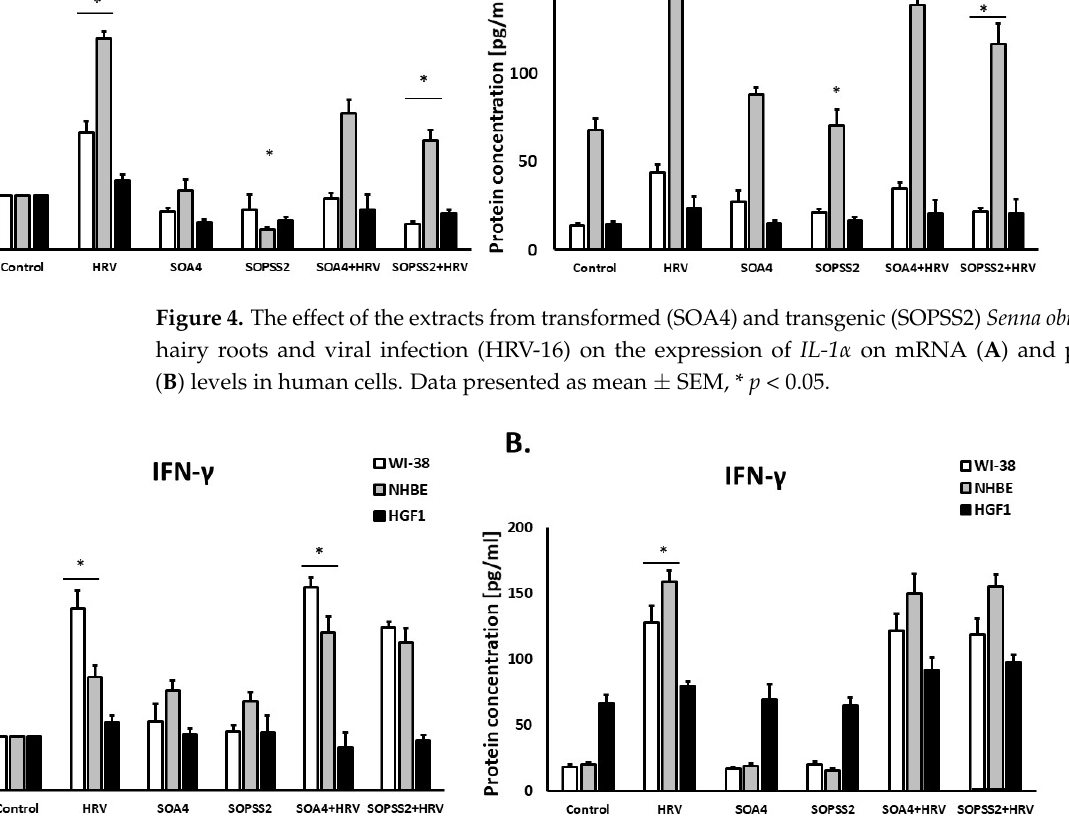
Figure 5. The lack of e ff ects of SOA4 and SOPSS2 extracts from Senna obtusifolia roots on IFN- γ expression on mRNA ( A ) and protein ( B ) levels. Extracts from transformed (SOA4) and transgenic (SOPSS2) Senna obtusifolia hairy roots. Data presented as mean ± SEM, * p < 0.05.